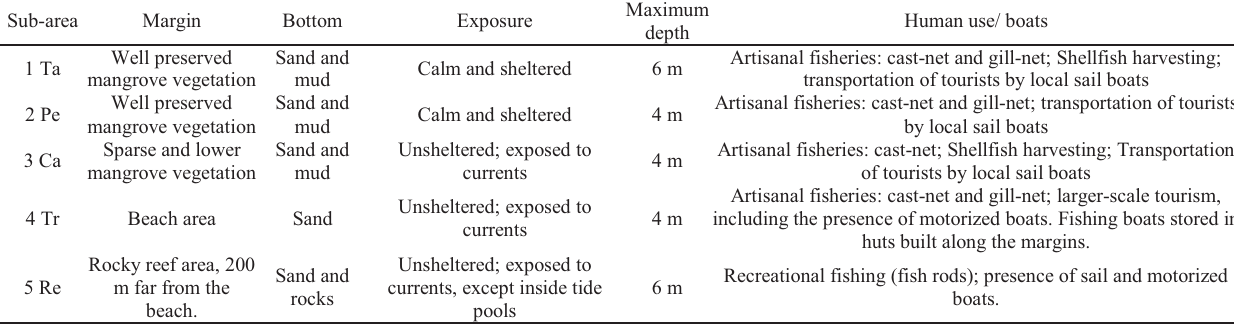
Table 1. Habitat features of studied sub-areas in the Mamanguape Mangrove-Reef system, State of Paraíba, NE Brazil, according to margin and bottom types, depth, currents, sedimentation, and human use. Sub-areas: 1. Ta - Tanques; 2. Pe - Peixe-Boi; 3. Ca -Cação; 4. Tr -Transition; 5. Re